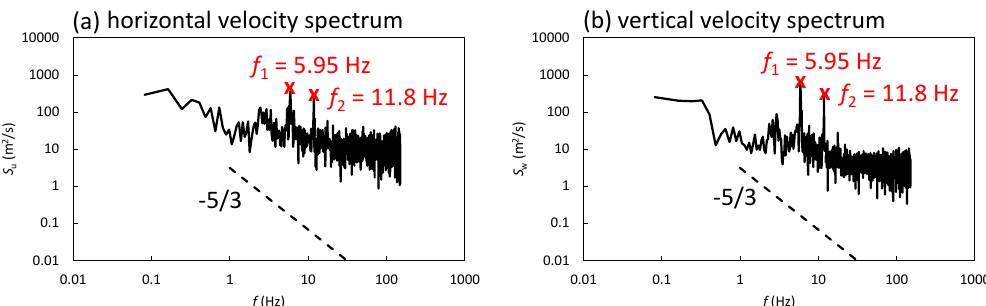
Figure 7. Power spectra of horizontal and vertical velocity fluctuations at a typical point of tip vortex shedding ( x = 0.5 D p , z = 0.7 D p ) at X w = 2 D p.